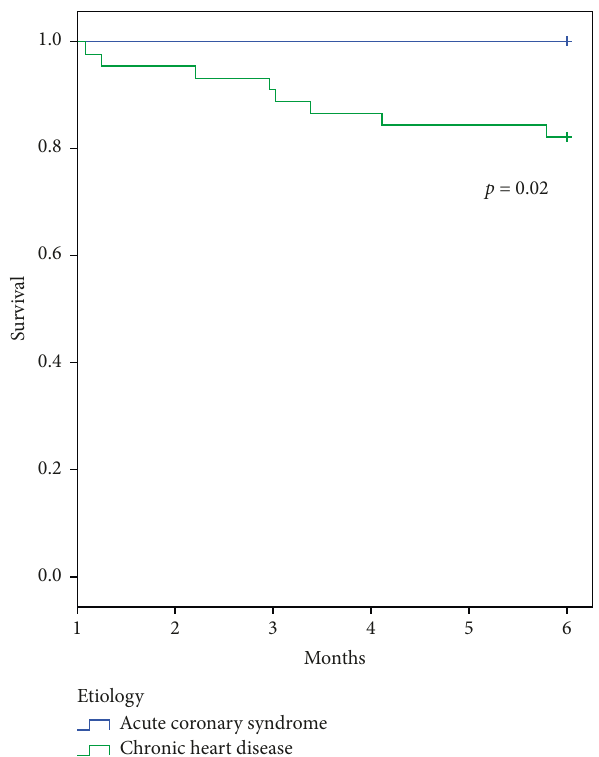
Figure 3: Comparison of Kaplan–Meier survival curves between CS related to ACS and CHF from 1 to 6 months (landmark analysis). This analysis shows a higher mortality between 1 and 6 months in patients with CHF complicated by a first occurrence of CS compared with ACS complicated by CS in survivors after the first